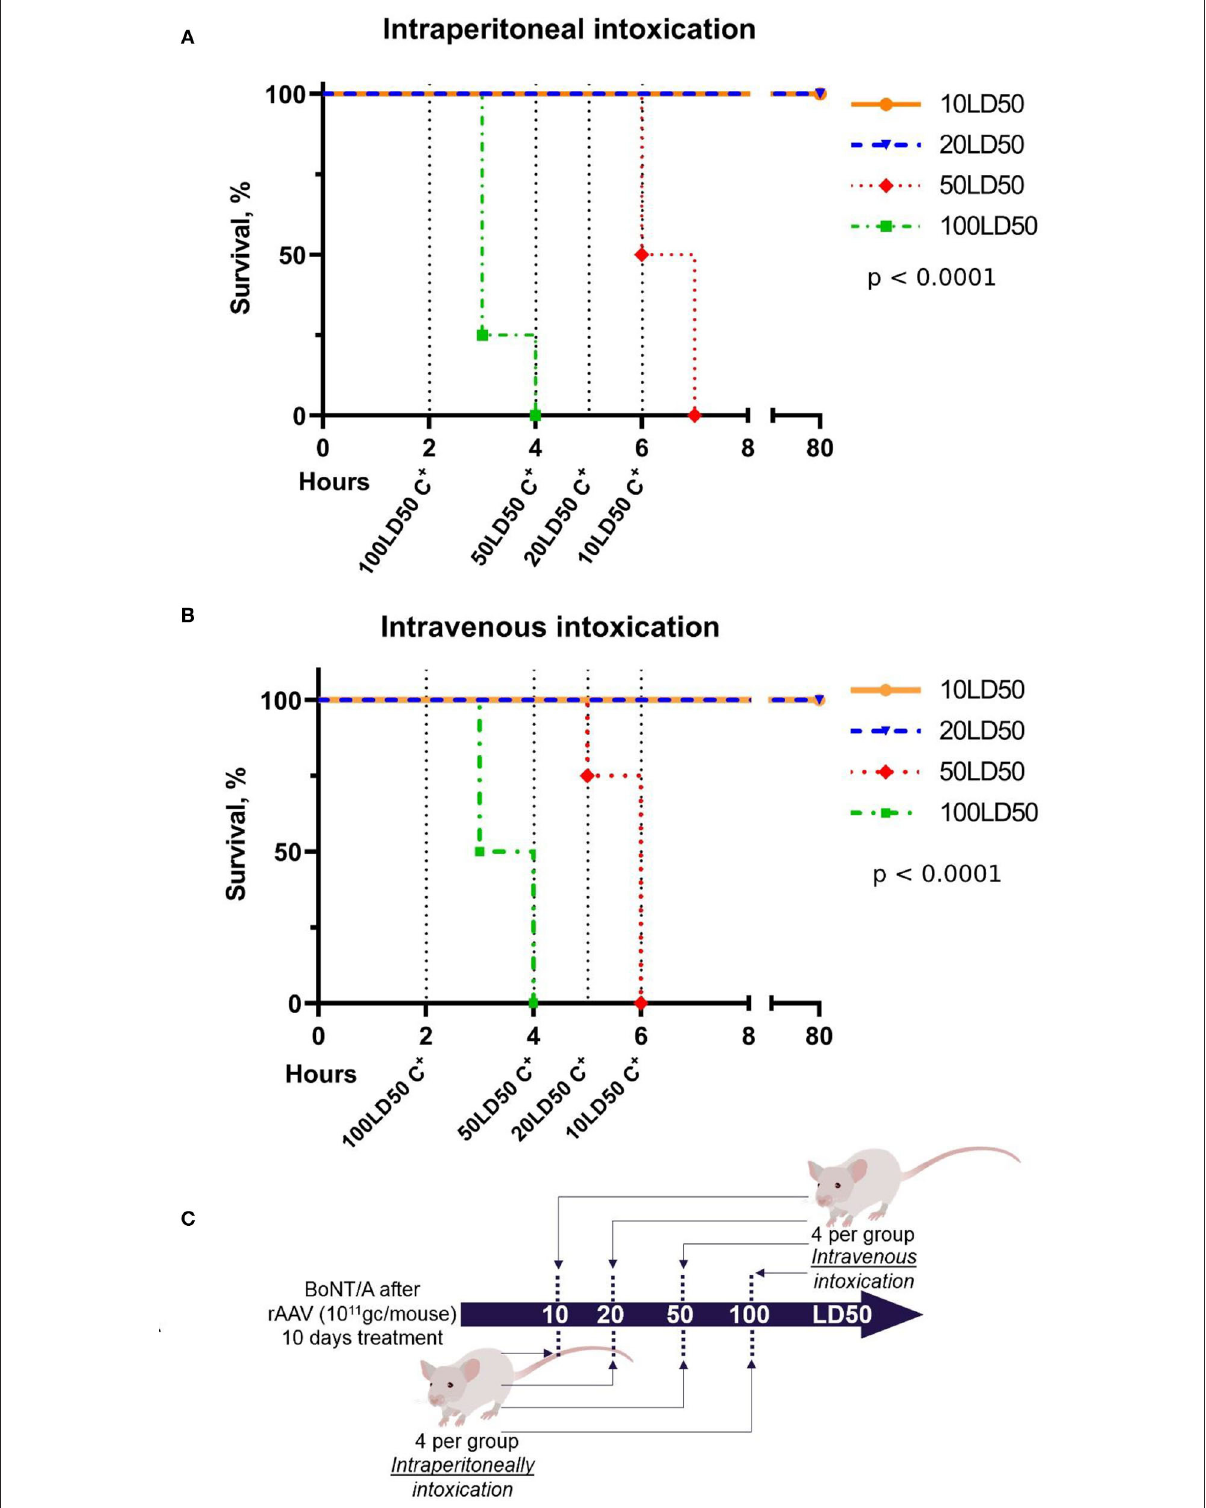
FIGURE6 Determination of the breakthrough dose of BoNT/A in intraperitoneal (A) and intravenous (B) intoxication 10 days after the administration of rAAV-B11-Fc according to the experimental scheme (C) . “C + ” on the graphs indicates the positive control of